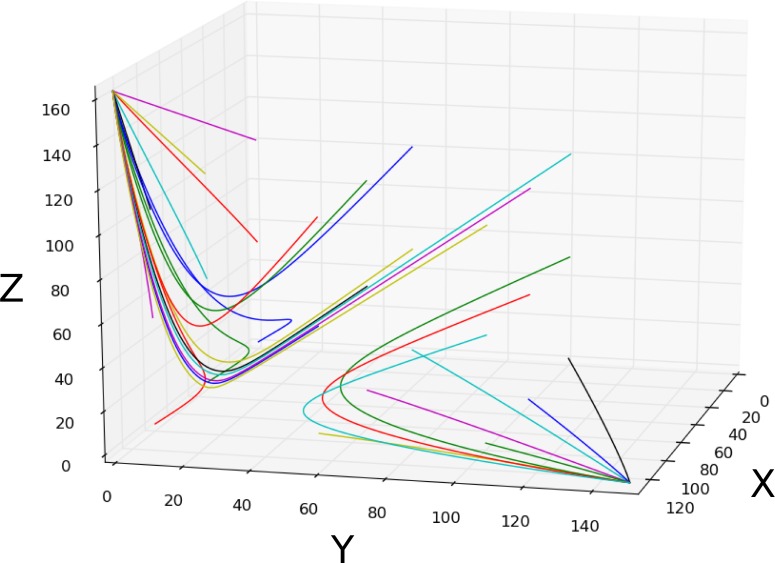
Bistability: simulation of the bistable dynamical regime.Trajectories with varying initial conditions (coloured curves) are shown to converge towards the two point attractors. This circuit was simulated using the connectionist formulation given by Equation 33, and the parameter values shown in Appendix 1—table 3.